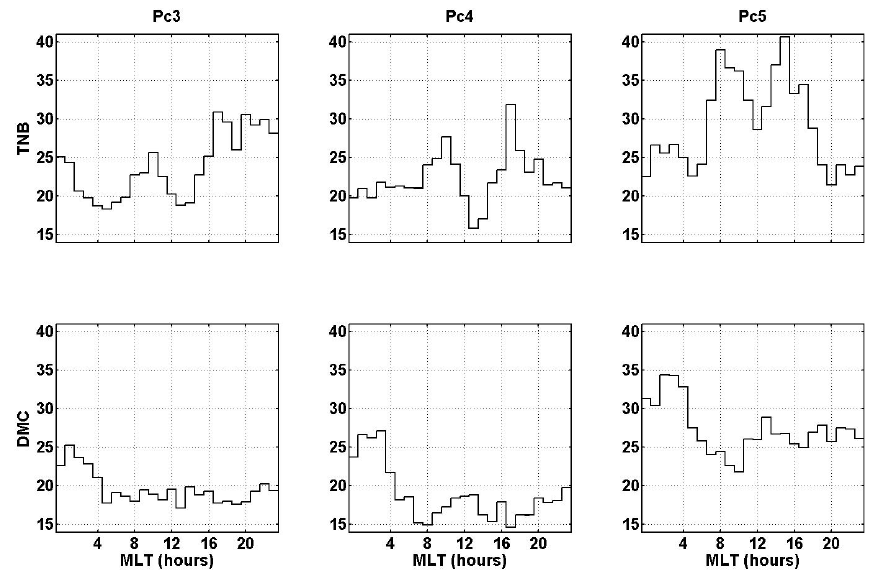
Fig. 5. MLT distribution of the percentage of polarized signals at DMC (bottom panels) and TNB (top panels) in the Pc5, Pc4 and Pc3 frequency band during the 2005–2007 local summer months.